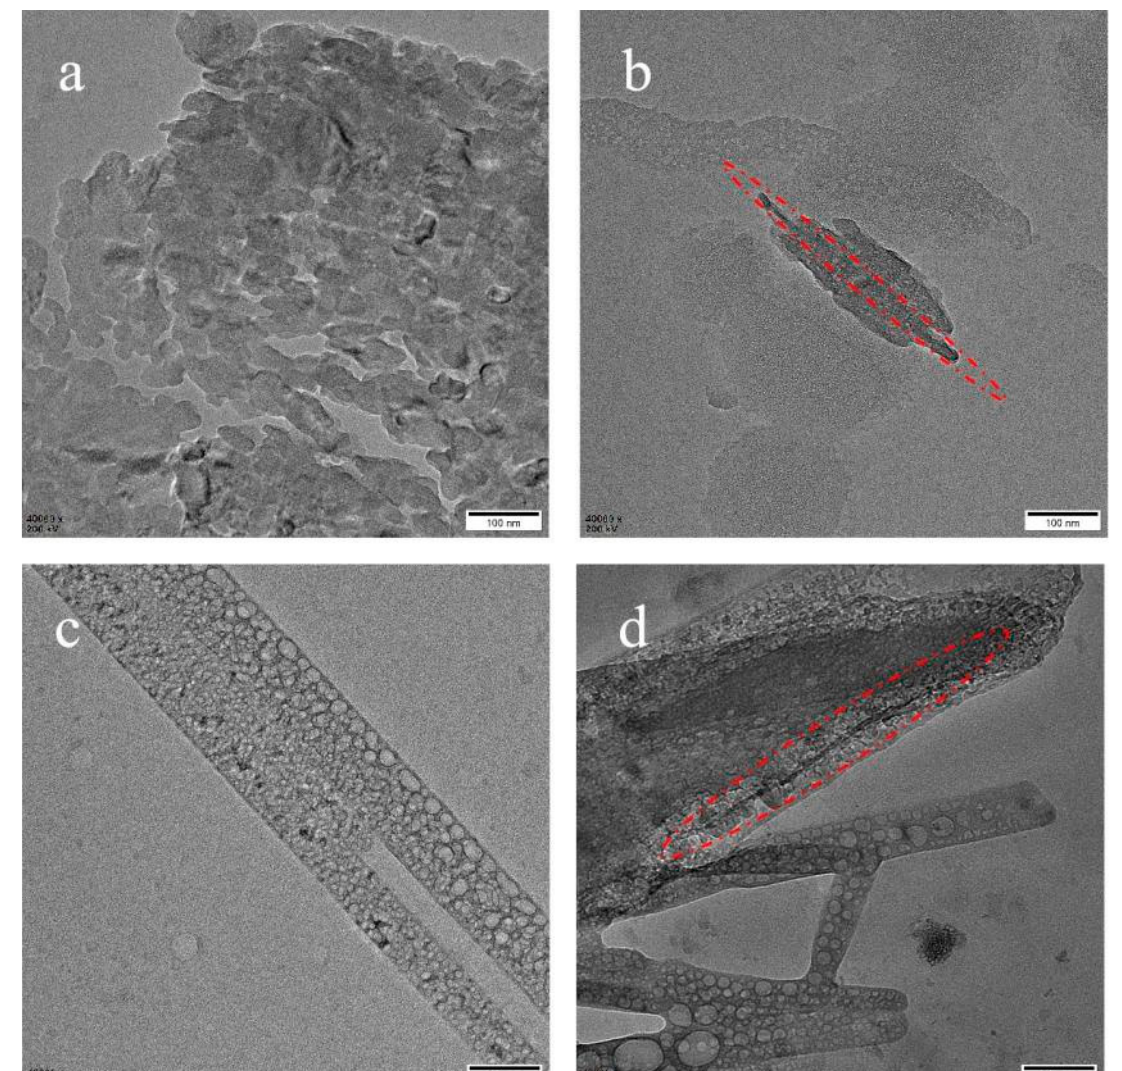
Figure 2. TEM of ( a ) melt blended PP/PTFE; ( b ) PP/PTFE/0.2 % MWCNTs; ( c ) PP/PTFE/0.5 % MWCNTs; ( d ) PP/PTFE/1 % MWCNTs.